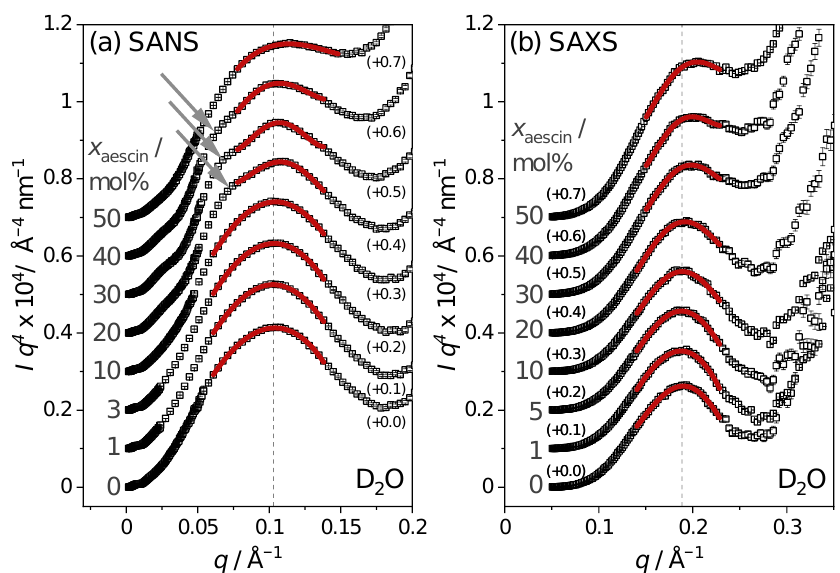
Figure 5. Modified Kratky–Porod plots of ( a ) SANS and ( b ) SAXS data obtained for samples with different x glycyrrhizin in D 2 O as solvent. Solid lines are 4th order polynomial approximations. The max- imum of these polynomial fits was used to determine the membrane thickness d MKP . A shoulder in the signal seen by SANS for samples with x glycyrrhizin between 20mol% and 40mol% is highlighted by gray arrows. The glycyrrhizin content x glycyrrhizin is denoted by numbers on the left. For better readability of the figure, the data are baseline-shifted by the numbers in brackets.